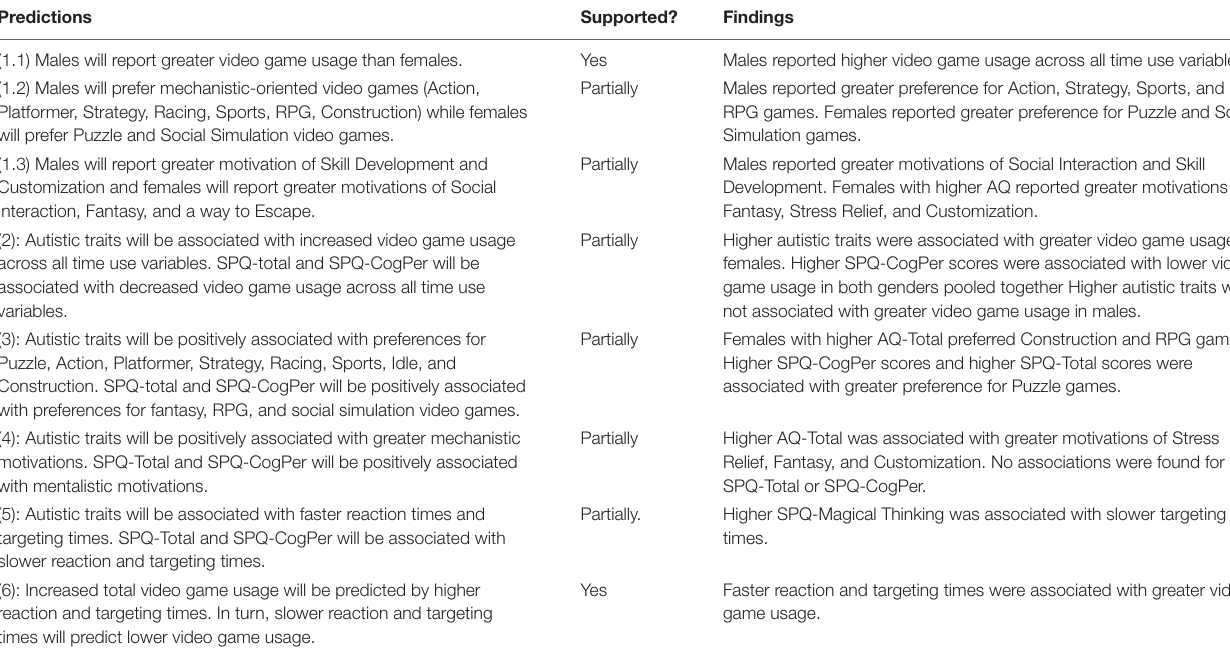
TABLE 2 | Study findings in relation to the main predictions. Predictions